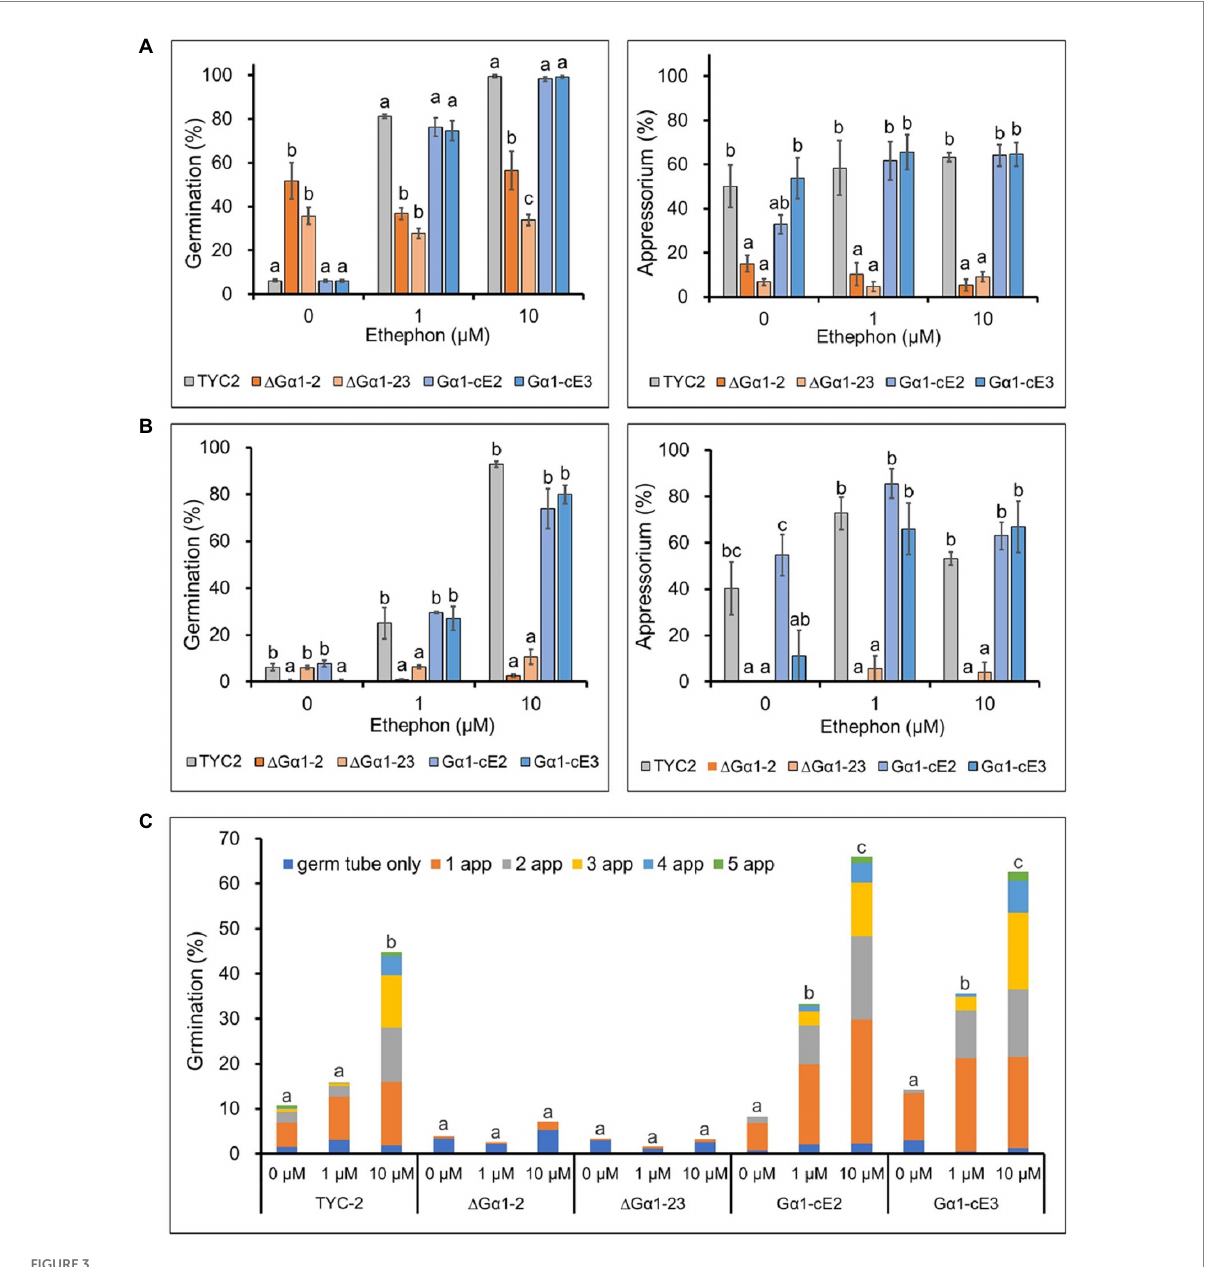
FIGURE 3 Spore germination and appressorium formation of Colletotrichum asianum wild-type strain (TYC-2), G 𝛼 1 mutants ( ∆ G 𝛼 1–2, ∆ G 𝛼 1–23) and gene complementation strains (G 𝛼 1-cE2, G 𝛼 1-cE3) on plastic petri dishes (A) and glass slides (B) at 3 h under 0–10 μ M ethephon treatments. The data within same treatment were analyzed by one-way ANOVA, different letters indicate significant differences between treatments ( p value <0.05). Multiple appressorium formation on glass slides at 48 h under 0–10 μ M ethephon treatments (C) . The multiple appressorium formation (>2 appressoria) percentage of all treatments was used for statistic analysis by one-way ANOVA, different letters indicate significant differences between treatments ( p value